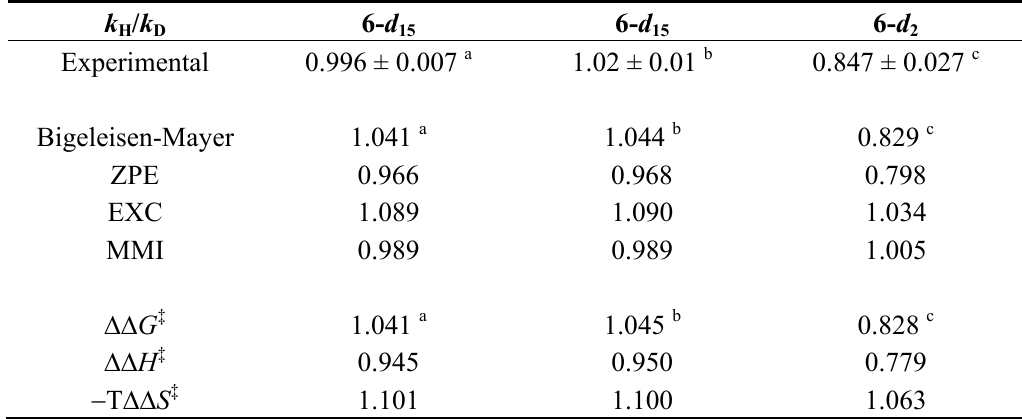
Table 2. KIEs for compound 6 using scaled B3LYP/6-31G(d,p) harmonic frequencies via the Bigeleisen-Mayer or  H  S approaches.